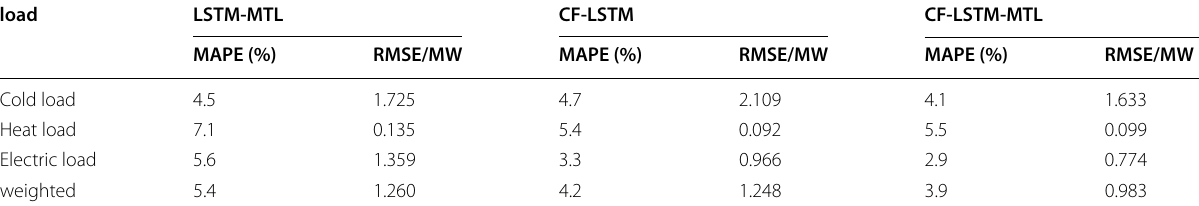
Table 3 Comparison of prediction performance load